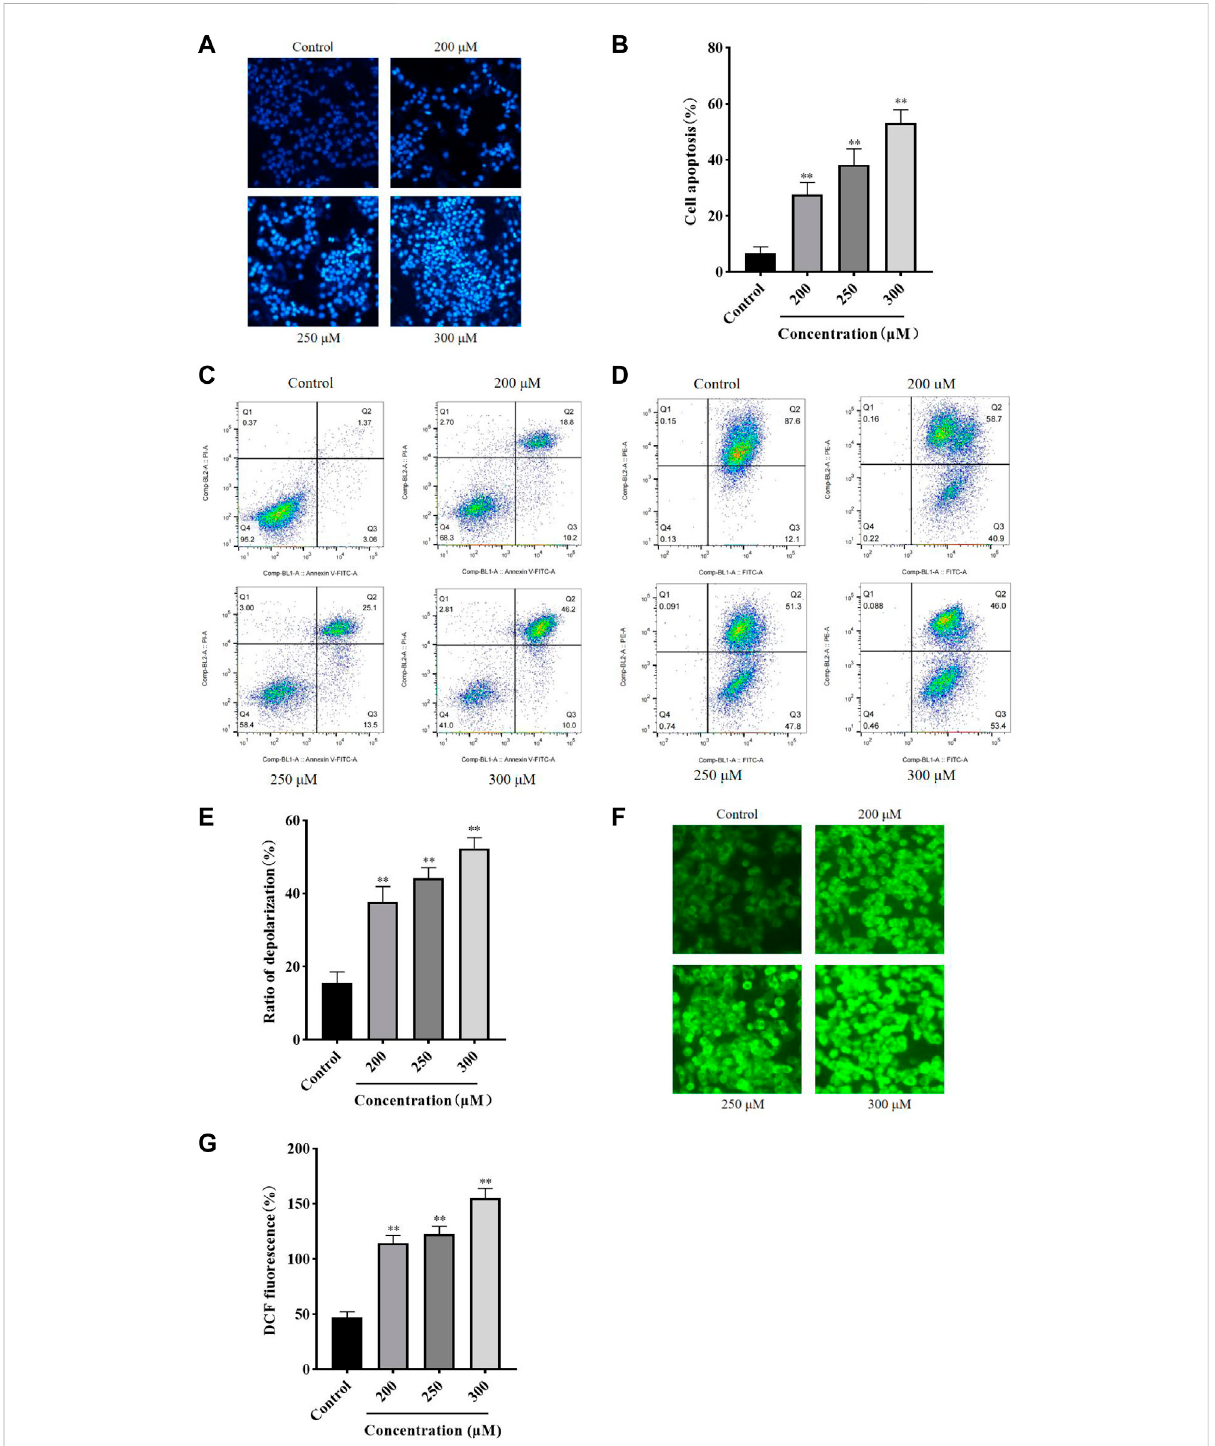
FIGURE 2 GA induced HCC1806 cells apoptosis accompanied by ROS accumulation and MMP depolarization. (A – C) Hoechst 33258 staining and fl ow cytometrywereperformedtoassesstheeffectofGAonHCC1806cellsapoptosis. (D,E) Thedepolarization ratioofHCC1806cellsweredetectedby fl owcytometry. (F,G) TheROSlevelofHCC1806cellswereassessedbya fl uorescencemicroscope.Datewereexpressedasmeans±SD.Compared with the control group, ** p <